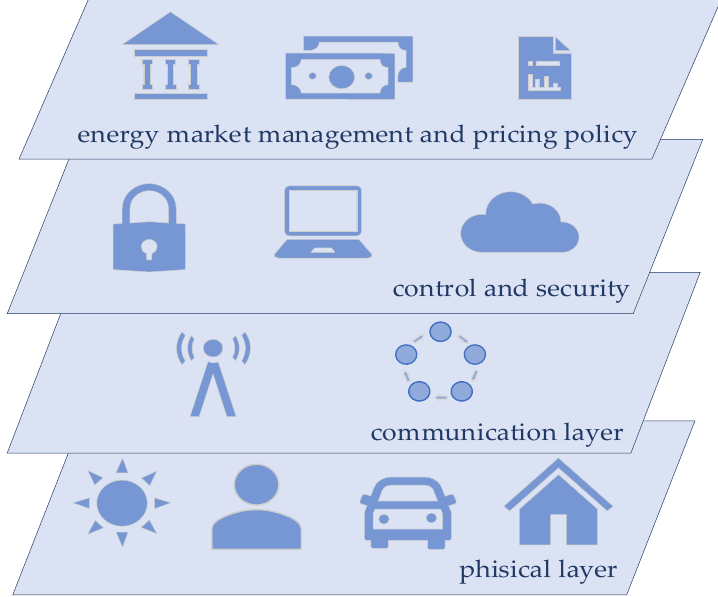
Figure 5. Concept of several layers of the command and control system of modern power grids.